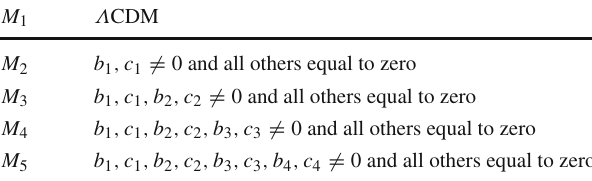
Table 2 Various models used in our analysis